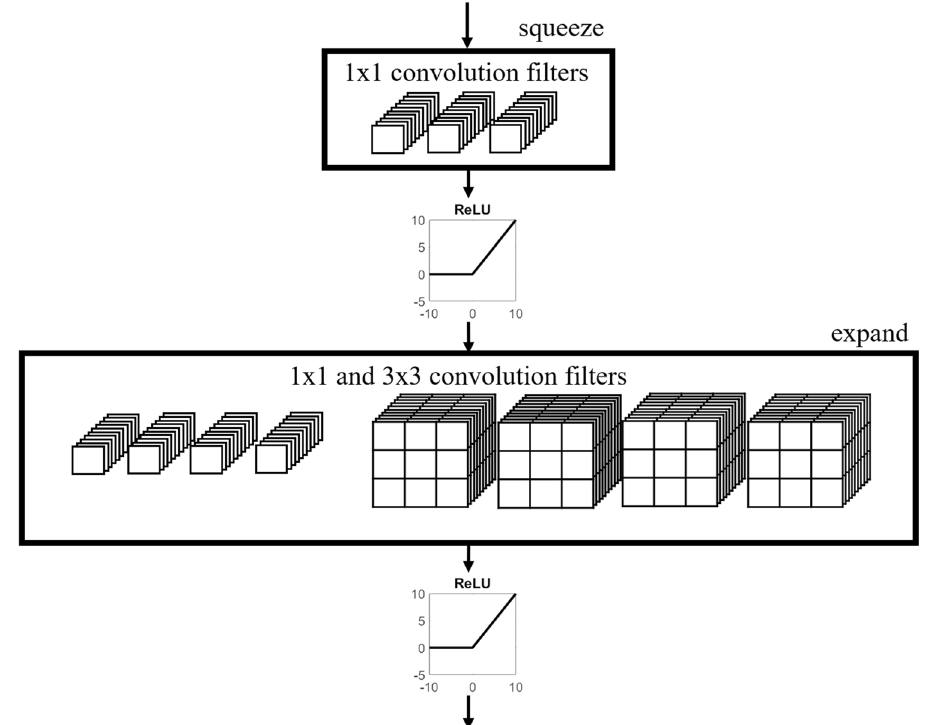
Fig. 7 Fire module of the SimKI